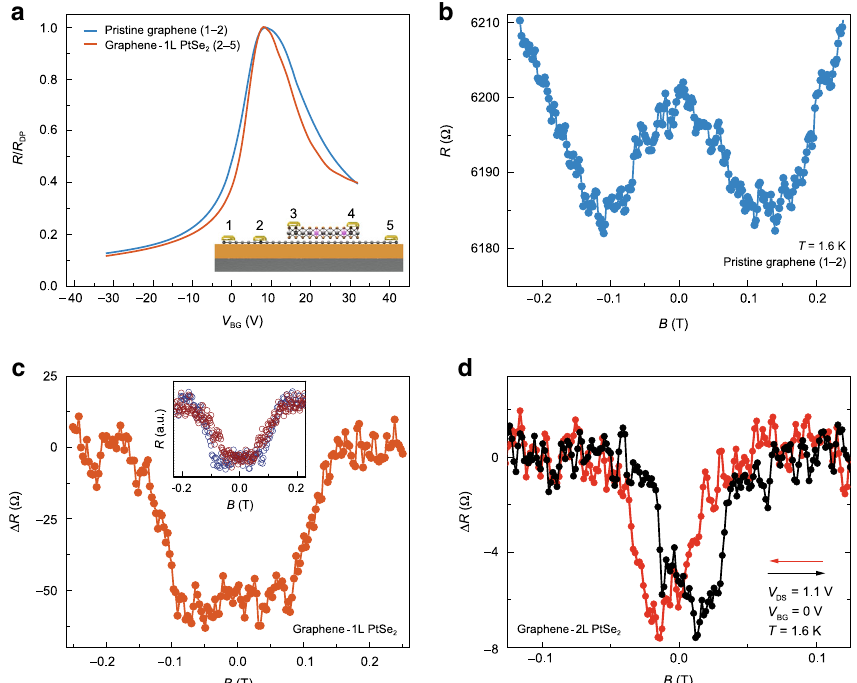
Fig. 3 Induced magnetization in monolayer graphene. a V BG dependence of graphene resistance. Red (blue) line represents the device with (without) a monolayer PtSe 2 on top of the graphene channel, between the voltage probes. Inset is the schematics of the measurement geometry. b Magnetic fi eld dependence of pristine graphene resistance measured at T = 1.6 K. c Magnetic fi eld dependence of graphene resistance measured at T = 1.6 K for the device with monolayer PtSe 2 on the channel. Inset shows the magnetic fi eld response of vertically measured monolayer PtSe 2 (red circles) and laterally measured graphene/monolayer PtSe 2 (blue circles). They have similar out-of-plane coercive fi elds. d Magnetic fi eld dependence of graphene resistance measured at T = 1.6 K for the device with a bilayer PtSe 2 on the graphene channel. Arrows represent magnetic fi eld sweep